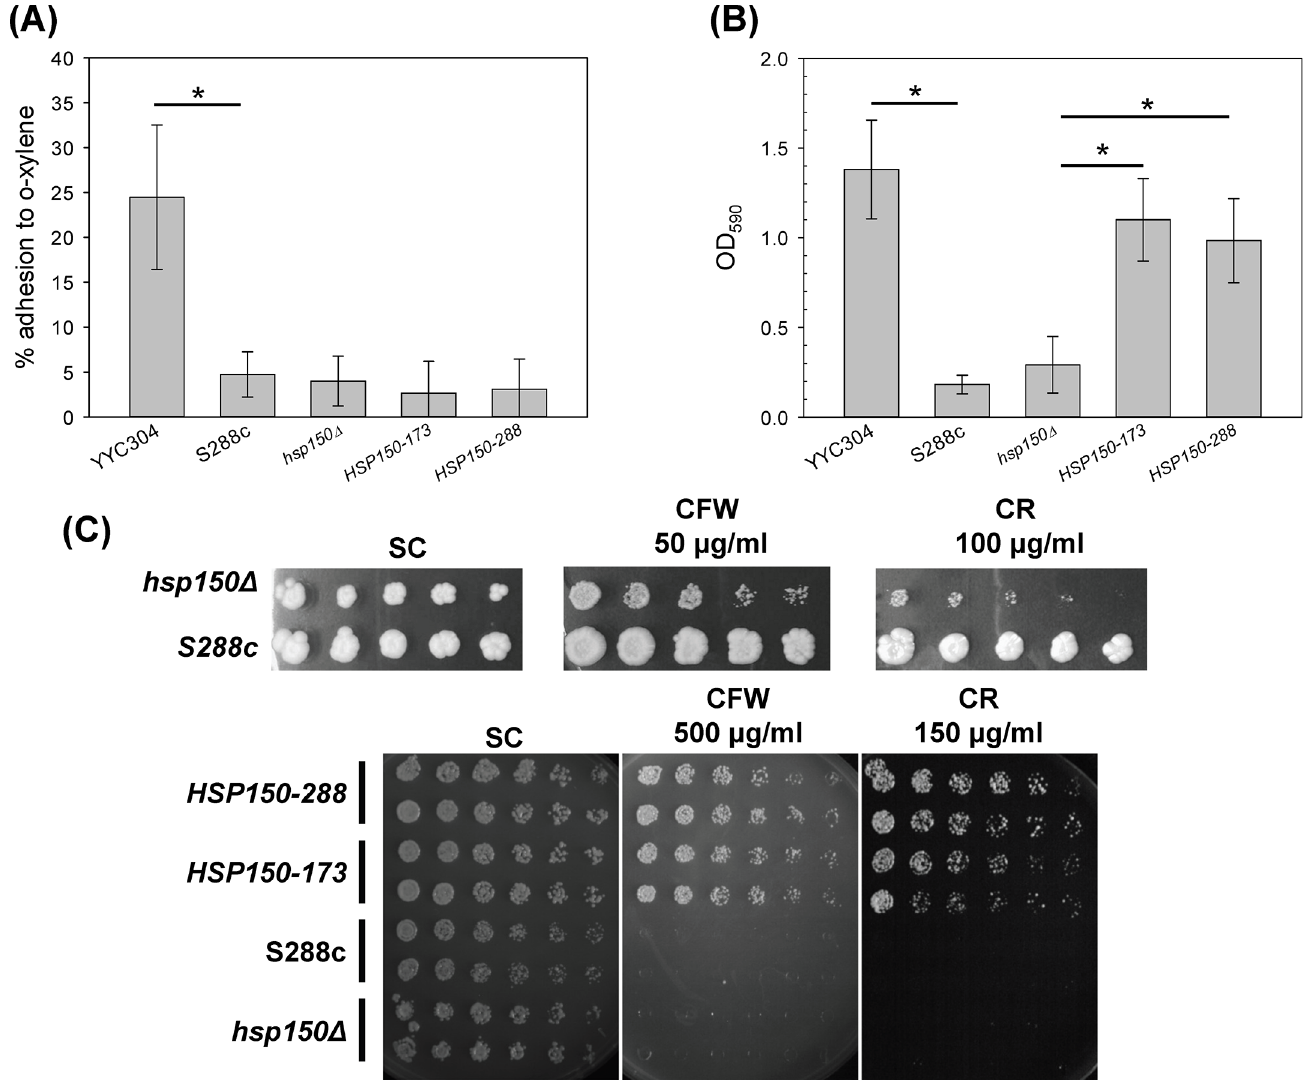
Fig 5. Overexpression of Hsp150p increased cell wall integrity and the ability of adherence to polystyrene surface. Strains S288c and YYC304 were served as negative and positive controls respectively. The hsp150 Δ strain containing the control vector, the allele HSP150-288 of S288c strain, or the allele HSP150-173 of YYC173, were subjected to cell hydrophobicity assay (A), adhesion assay (B), and sensitivity assay with CFW or CR with indicated concentrations (C) as described. Serial 2-fold dilutions of each strain were spotted on solid SC-galactose media or in the presence of CFW or CR. The plates were incubated at 30°C for 3 days. 3 biological replicates were performed. Asterisks indicate statistically significant differences ( p <